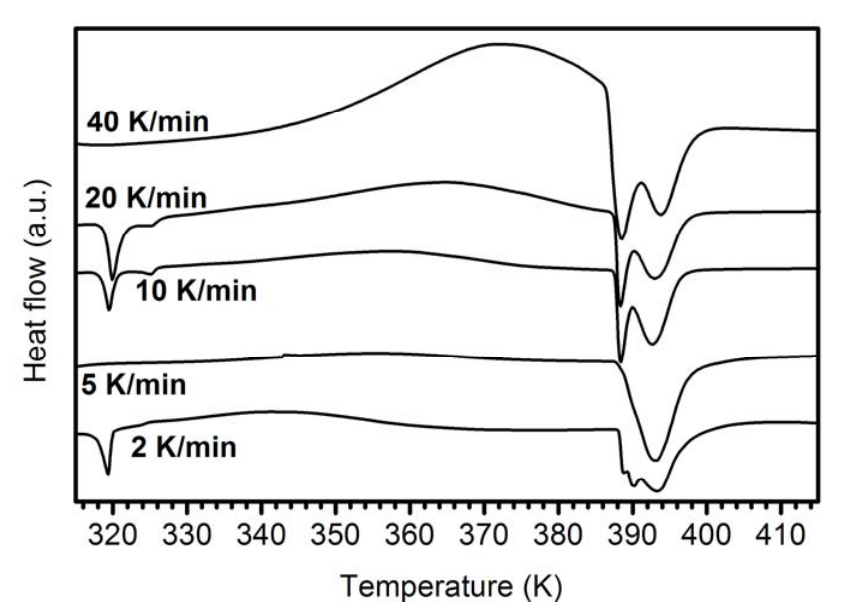
Figure 7. Scanning PDSC traces under 2 bar of hydrogen pressure of one hour milled LiBH